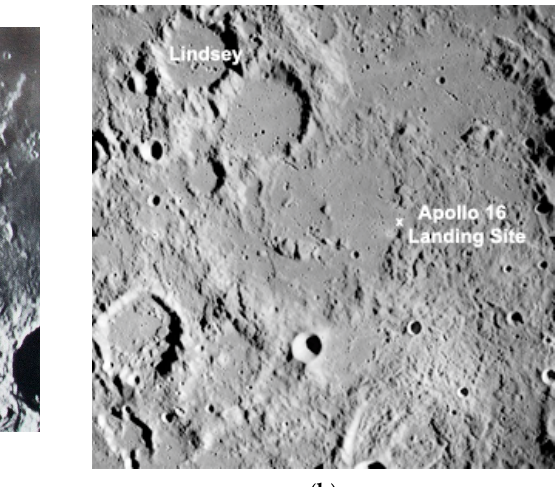
Figure 10. The landscape at the Apollo 16 landing site, near the Nectaris basin, but also amidst the topographic features radial to Imbrium basin. As suggested here, craters may have excavated Imbrium blanket material and/or underlying Nectaris materials. (Glare from the sun appears at right. Photo mosaic from Lunar and Planetary Institute web site). In short, there is growing evidence that Nectaris (or at least some basin-scale impacts sampled by Apollo 16) may date from well before the alleged basin-forming spike around 3.9 Ga ago. In that case, the “traditional” radiometric/petrologic methodology, assuming that Apollo sample ages at ~3.8 to ~4.0 Ga (a range of 1, 2, 3 investigator-cited error bars) refers to many individual nearby basins (rather than Imbrium ejecta) has been too simple. A fourth example of problems with the radiometric/petrologic approach comes from Wilhelms (1987 [73]), who acknowledged problems with the methodology but listed the Crisium basin as younger than the Imbrium basin (within an error bar). This radiometric result seems dubious, based on the data in Table 2 and the near absence of a visible multi-ring system around Crisium. In Table 2, all but one of the rankings list Crisium as older than Imbrium. The ratios of Crisium/Imbrium crater densities, as listed from Hartmann and Wood (1971 [20]) and from Fassett et al. (2012 [88]) N(20) and N(64) counts, are high—6.8, 3.9, and 2.0, respectively—indicating an older age for Crisium (though we note again, that if most basins formed during a 150 Ma bombardment, short time intervals would